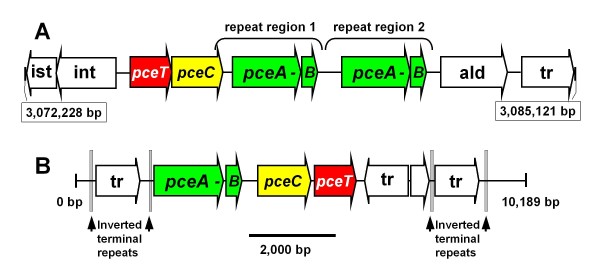
PCE dehalogenase (Pce) genomic island on theG. lovleyistrain SZ chromosome (CP001089; Glov_2866-Glov_2875) (Panel A) compared to the transposon-encodedpce-gene cluster fromDesulfitobacterium hafniensestrain TCE1 (AJ439608) (Panel B). The transposase-associated pce-gene clusters in the genomes of D. hafniense strain Y51 (AP008230) and Dehalobacter restrictus PER-K23 (AJ439607) share 99% nucleotide identity with the strain TCE1 pce-gene cluster. Inferred gene functions are abbreviated as follows: pceA - putative tetrachloroethene (PCE) dehalogenase, pceB - membrane anchor protein subunit, pceT - peptidylprolyl-cis-trans-isomerase, pceC - FMN-binding and polyferredoxin domain protein, int - integrase, ist - ATPase, tr‒transposase, and ald‒aldehyde dehydrogenase. The pceA-pceB ORFs are duplicated within the strain SZ genomic island, and associated with transposase genes, but no inverted repeats were detected. In contrast, the RDase genes in strain TCE1 are associated with both transposases and inverted repeats, and the overall structure of the element in TCE1 resembles a composite transposon.